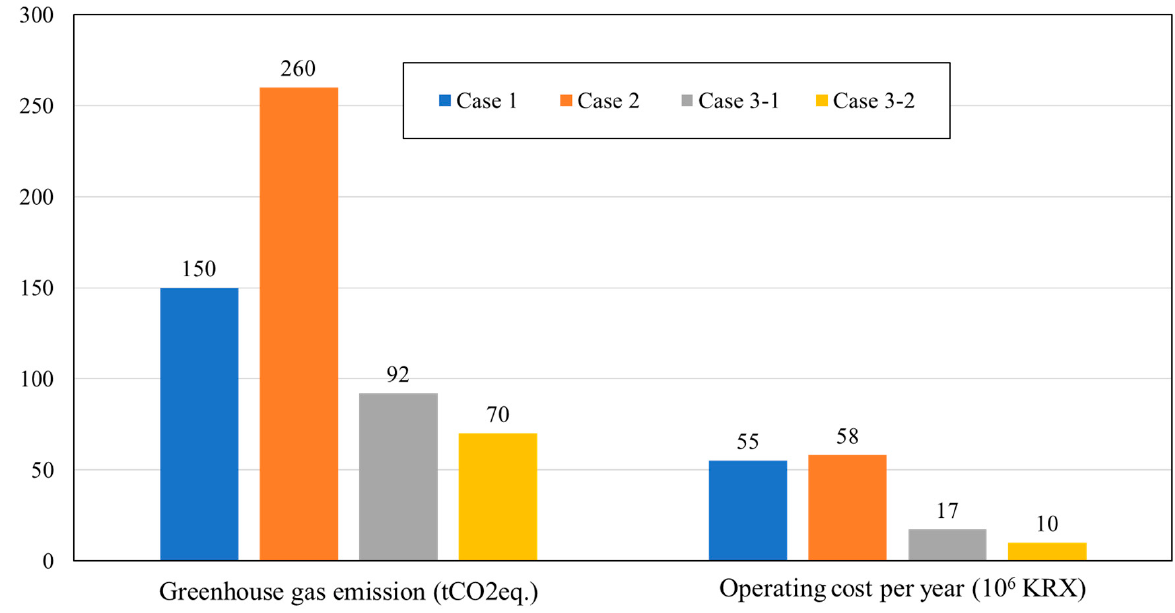
Figure 7. Greenhouse gas emission and operating cost of comparative systems.